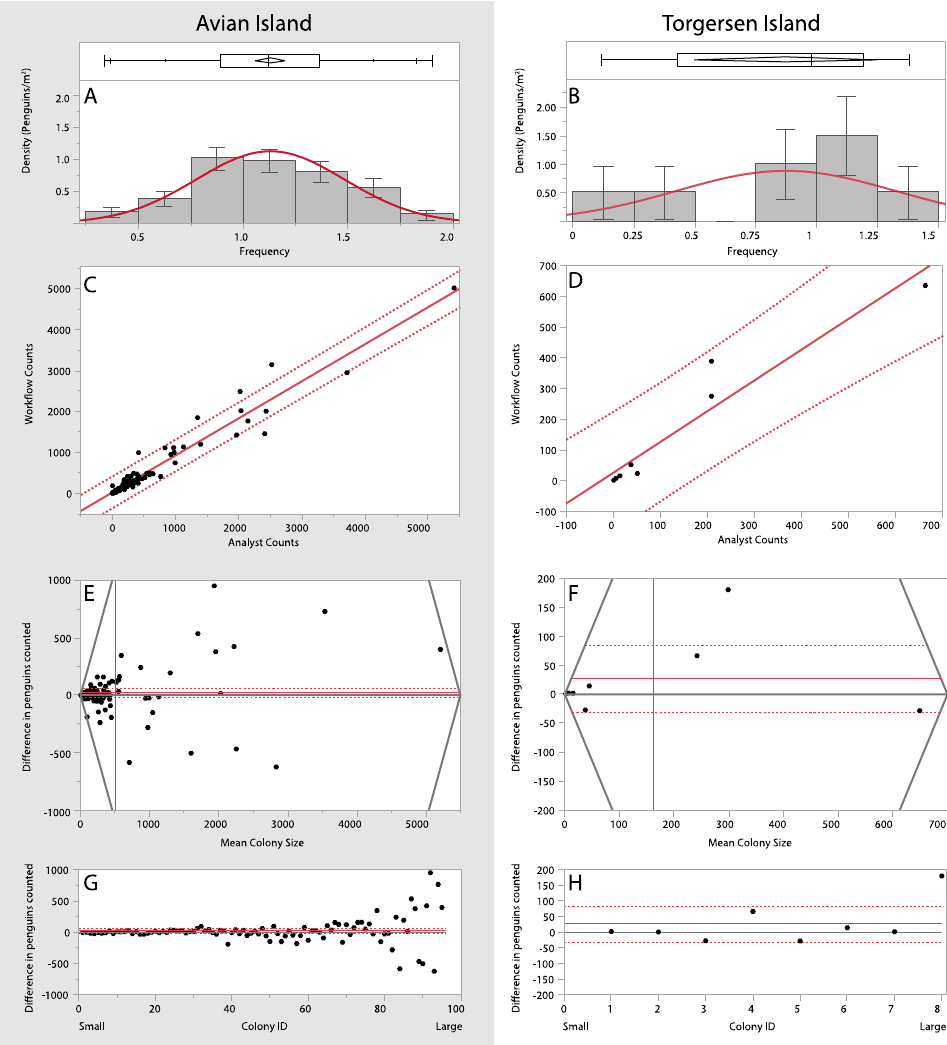
8.49) and the workflow count (1401) on Torgersen Island; t (7) = − 1.09, p = 0.31. Figure 4G,H show that the difference between the analyst average count and the workflow count increases with colony size.